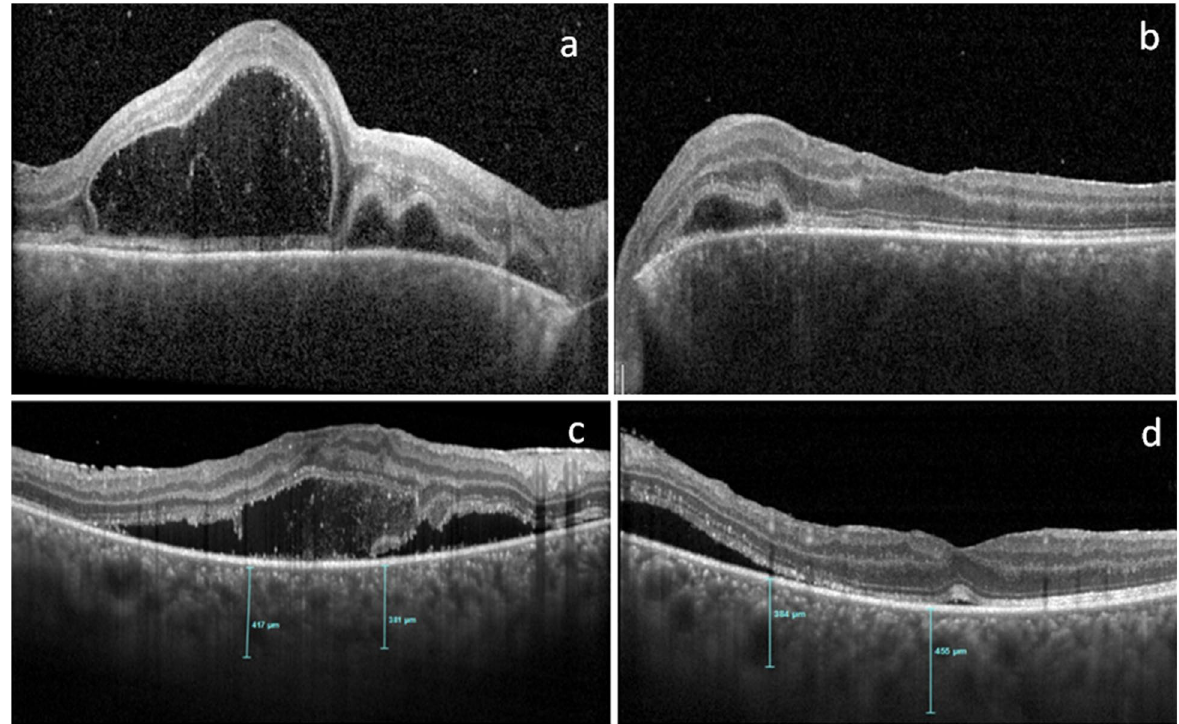
Fig. 4 a and b : right and left eye enhanced depth imaging (EDI-OCT) showing beyond measurement choroidal thickening with exudative retinal detachment more in the right eye. c and d : EDI-OCT showing improvement in subretinal fluid and choroidal thickness (but still high, central choroidal thickness: 417 micron right eye and 456 micron left) after IV pulse